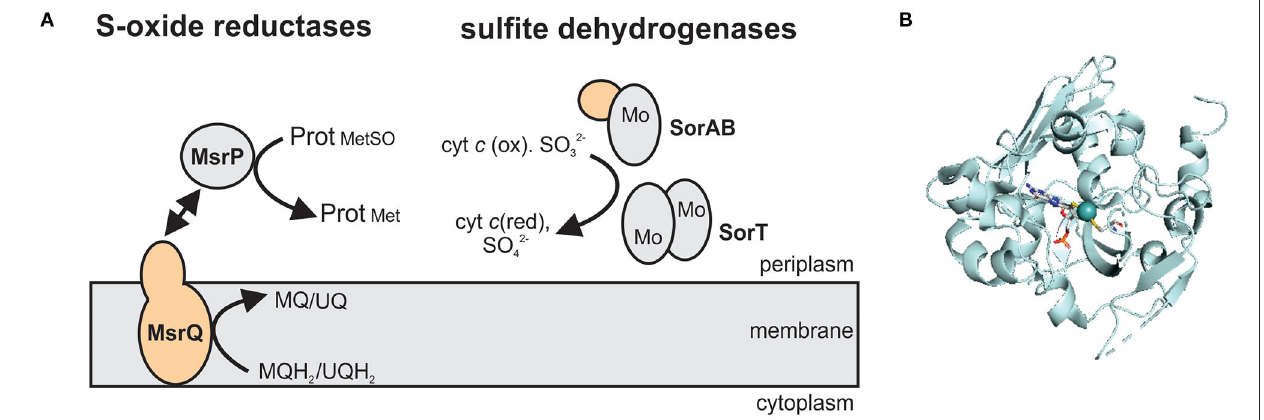
FIGURE 4 | The structure and subcellular location of SO family enzymes associated with bacterial virulence. (A) Overview of enzyme structures. SorAB and SorT are two types of sulfite dehydrogenases that oxidize sulfite to sulfate, while the MsrP protein reduces protein-bound methionine sulfoxides with electrons transferred from the membrane integral cytochrome MsrQ. Gray – Mo-binding subunit; orange – heme-binding subunits. MQ – menaquinone; MQH 2 - menaquinol; UQ – ubiquinone; UQH 2 – ubiquinol. (B) Crystal structure of the methionine sulfoxide reductase MsrP from Escherichia coli (PDB: 1XDQ) with the Mo-PPT cofactor shown in stick form. Colors: white – carbon, blue – nitrogen, orange – phosphor, red – oxygen, yellow – sulfur, light teal – molybdenum, protein backbone –